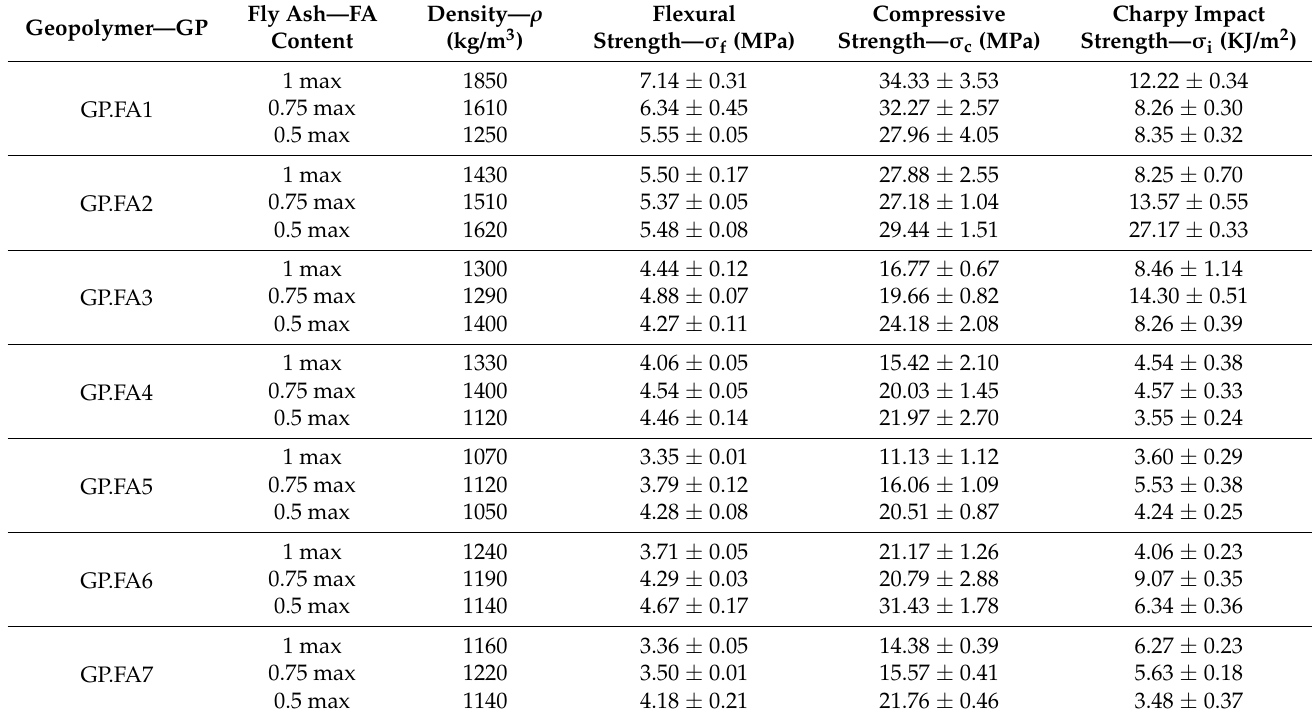
Figure 3. The flexural strength of the geopolymers synthesized with fly ash from thermal power plants was evaluated. The standards used were STD1, which is a geopolymer without fly ash, and STD2, which is the concrete Baumit 25.